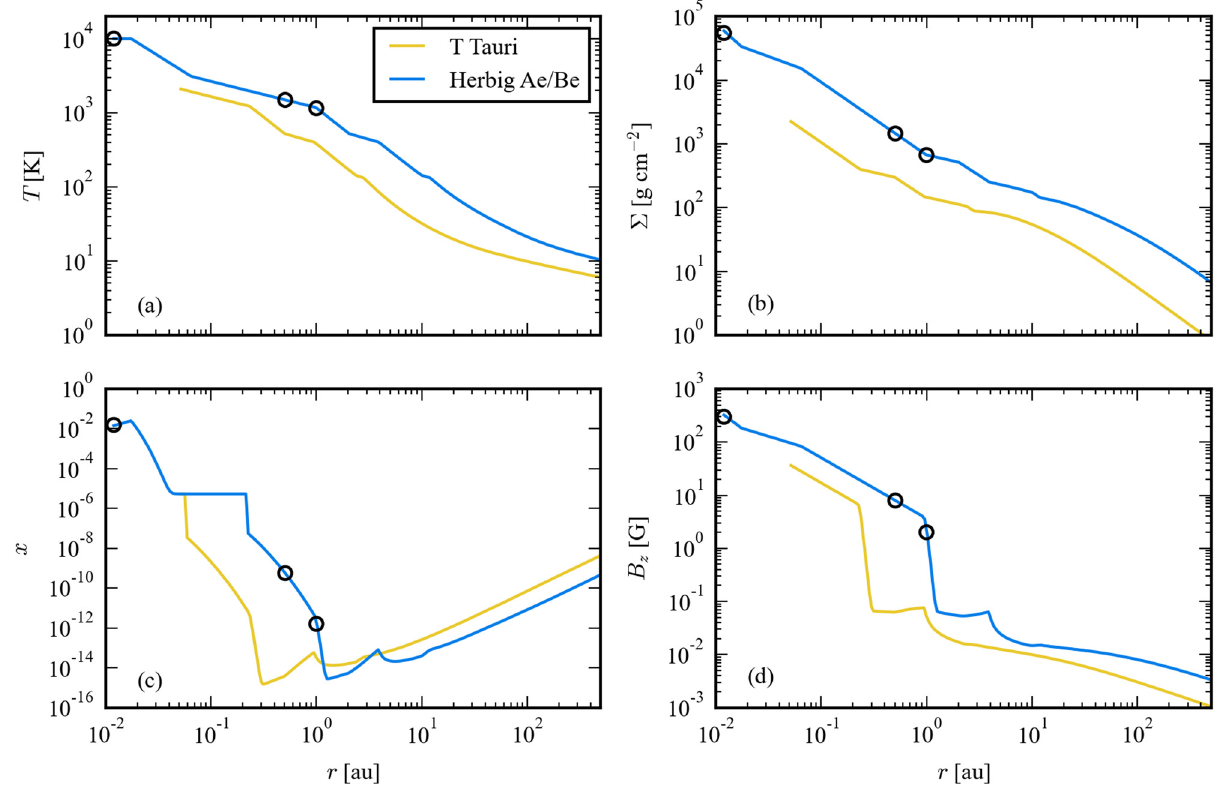
Figure 1: Radial pro fi les of the midplane temperature ( a ) , surface density ( b ) , midplane ionization fraction ( c ) , and midplane magnetic fi eld strength ( d ) in the accretion disks of typical TTS ( yellow lines ) and HAeBeS ( blue lines ) . Empty circle markers show the points at which the modeling of the dynamics of the MFT was